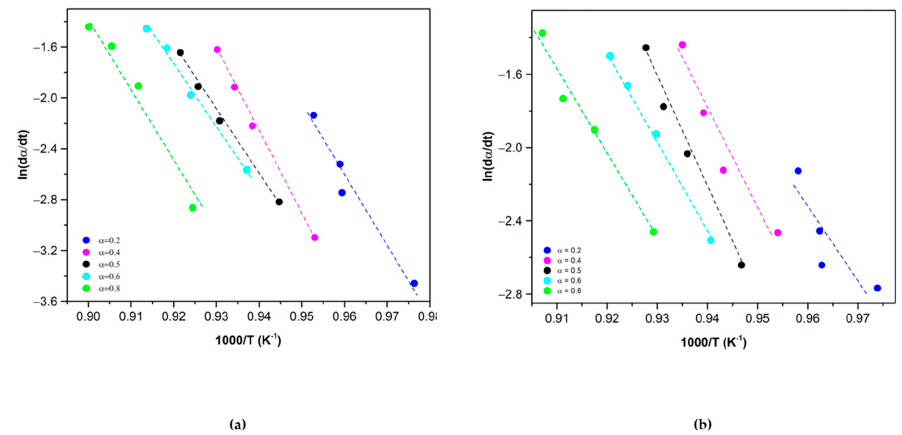
Figure 3. Friedman plot for the reduction of ( a ) Co 2.4 Ni 0.6 O 4 and ( b ) 0.5% SiO 2 /Co 2.4 Ni 0.6 O 4 for different conversion ratios.